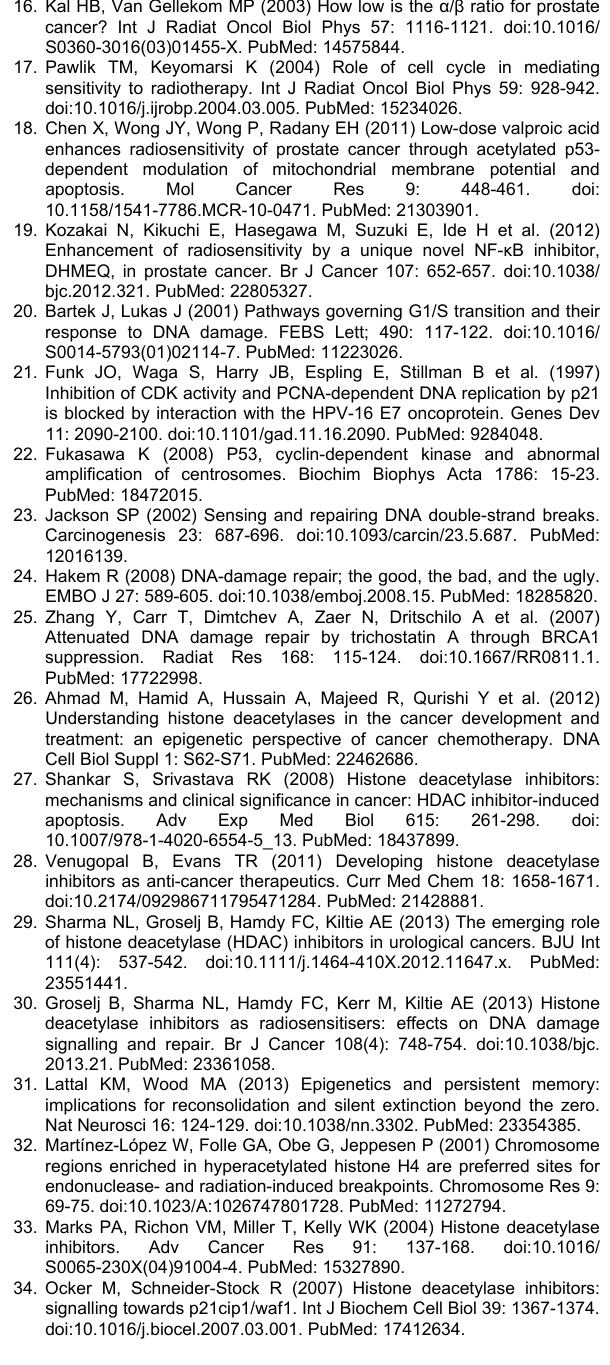
Figure S5. Representative images of cell cycle histograms of LNCaP cells after combination treatment of LBH589 and 2 Gy RT from 0 to 72 h